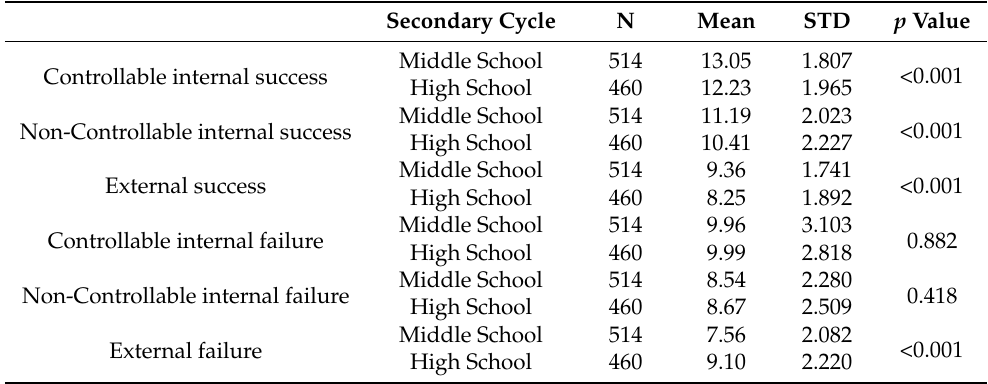
Table 3. Results of the ANOVA test between ASFAQ and the school cycle. Secondary Cycle N Mean STD p Value Controllable internal